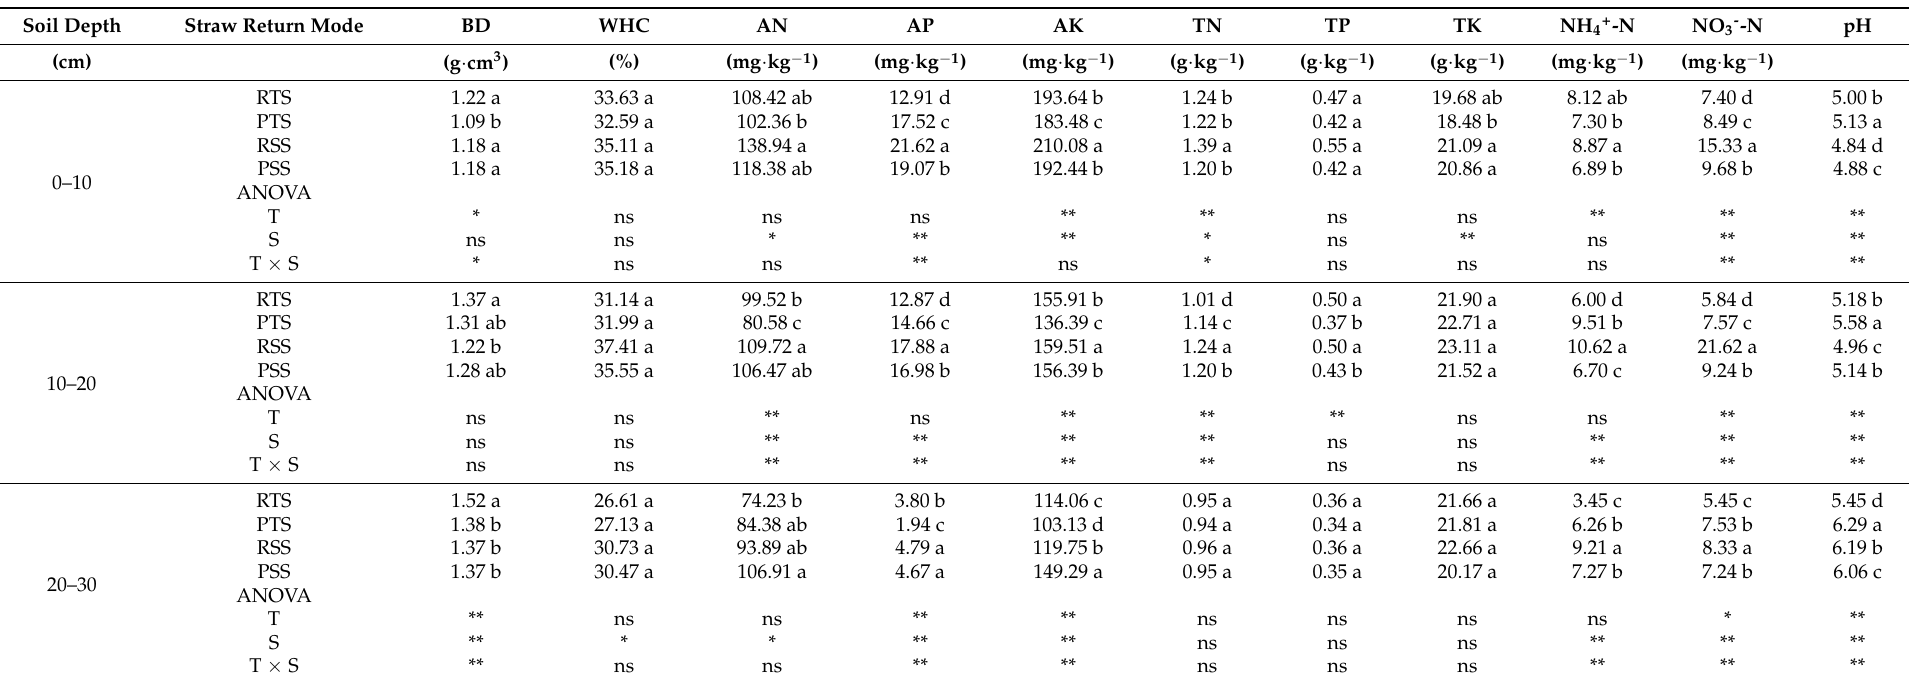
Table 1. Effect of tillage and straw return mode on the physicochemical properties of the soil